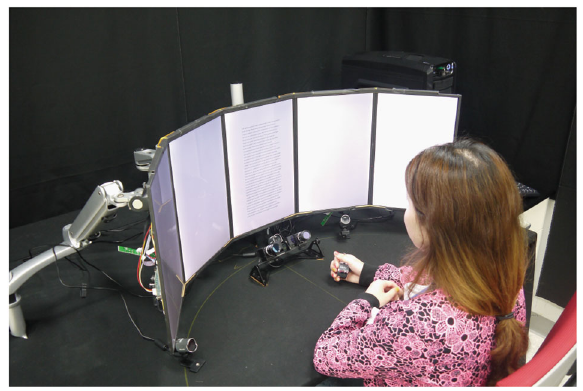
Fig. 17 Visual ergonomics research on new types of